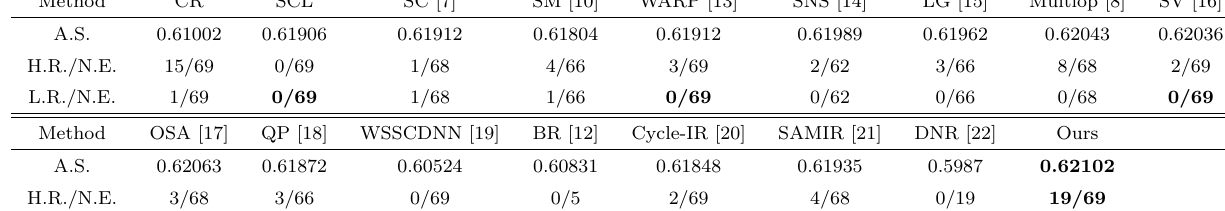
Table 1 GRNN-OQA scores. A.S. = average score. H.R. = number of highest-scoring results over all methods. L.R. = number of lowest-scoring results over all methods. N.E. = number of results generated by the corresponding method. Best results are shown in bold Method